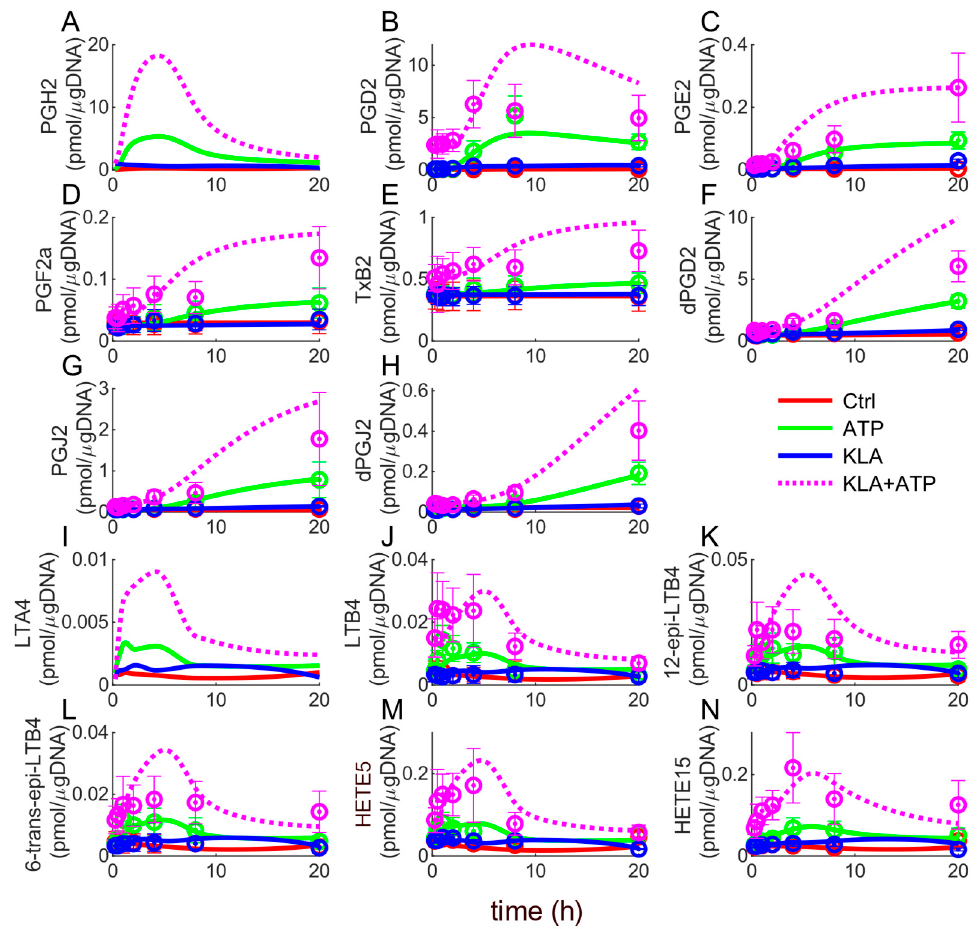
Supplementary Table S4. The F-test values for the fitted data are smaller than F 0.05 (21, 42) = 0.51 for all metabolites except PGE 2 , indicating that the fit-error is less than the experi- mental error. Even in the case of PGE 2 , although the F value is greater than F 0.05 (21, 42), it is still less than F 0.95 (21, 42) = 1.81, indicating statistically equal variance between the sim- ulated and experimental data [38]. F-test values for the predicted case also display similar results, further validating the model.